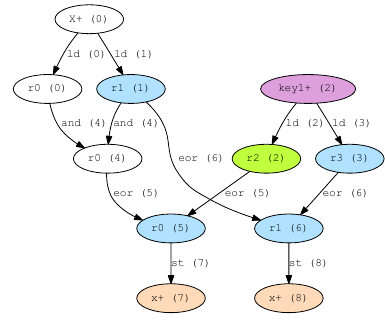
Figure 2: Updated graph generated by TADA after a successful attack on target node r1(1) from vulnerable instruction 4 of example cipher F ex in Table